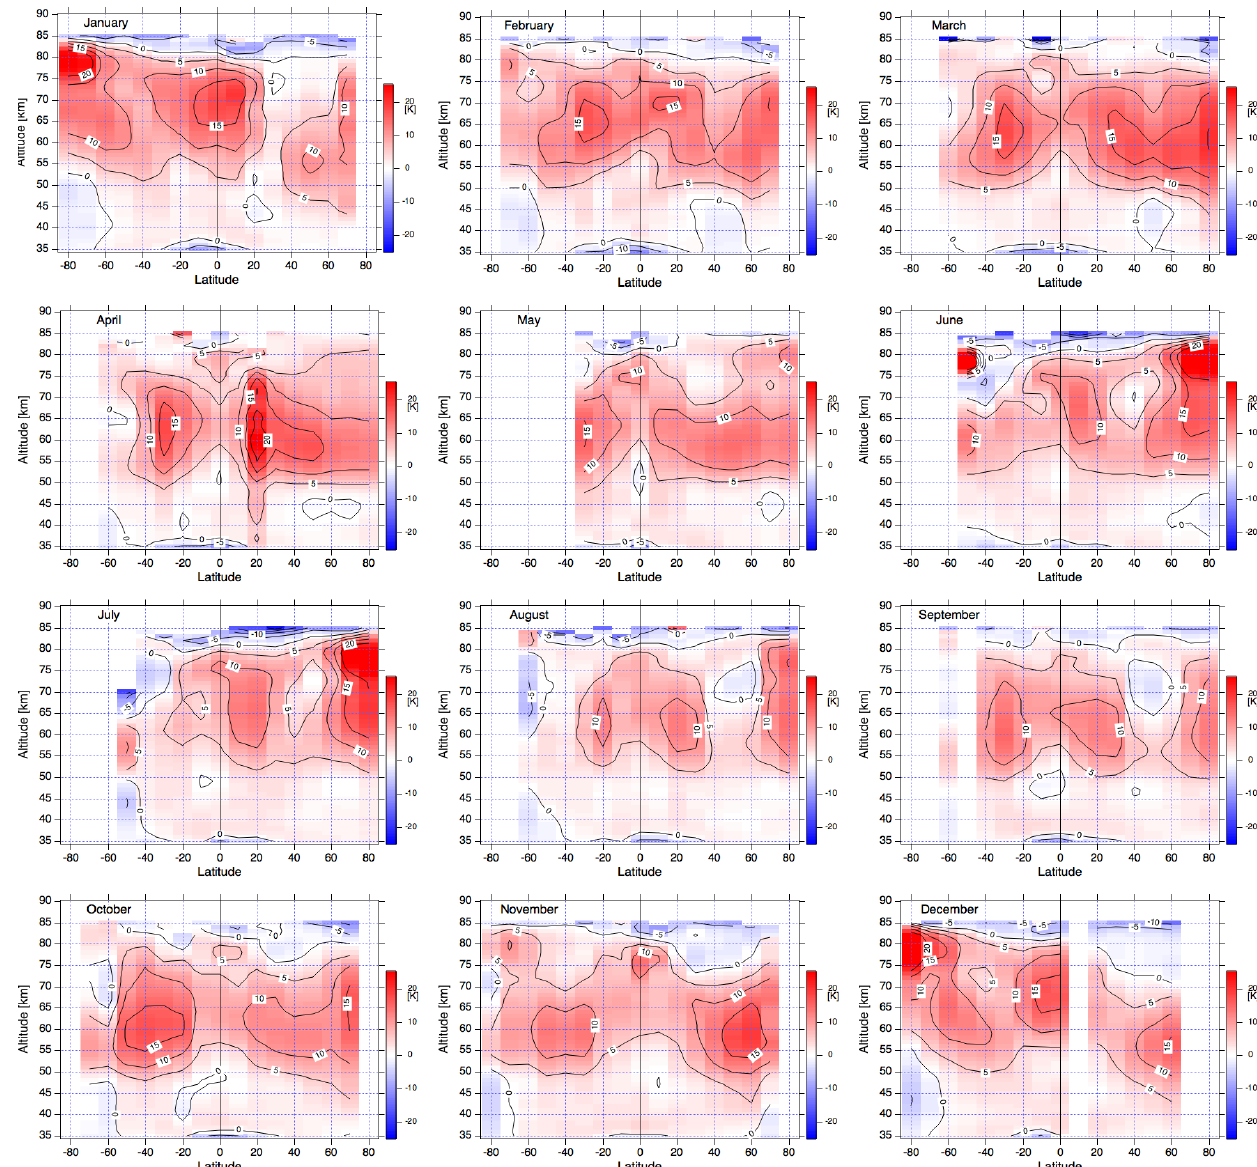
Figure 7. Monthly climatology of the temperature difference between GOMOS and the external (ECMWF + MSIS). Data are averaged over 10 ◦ latitude